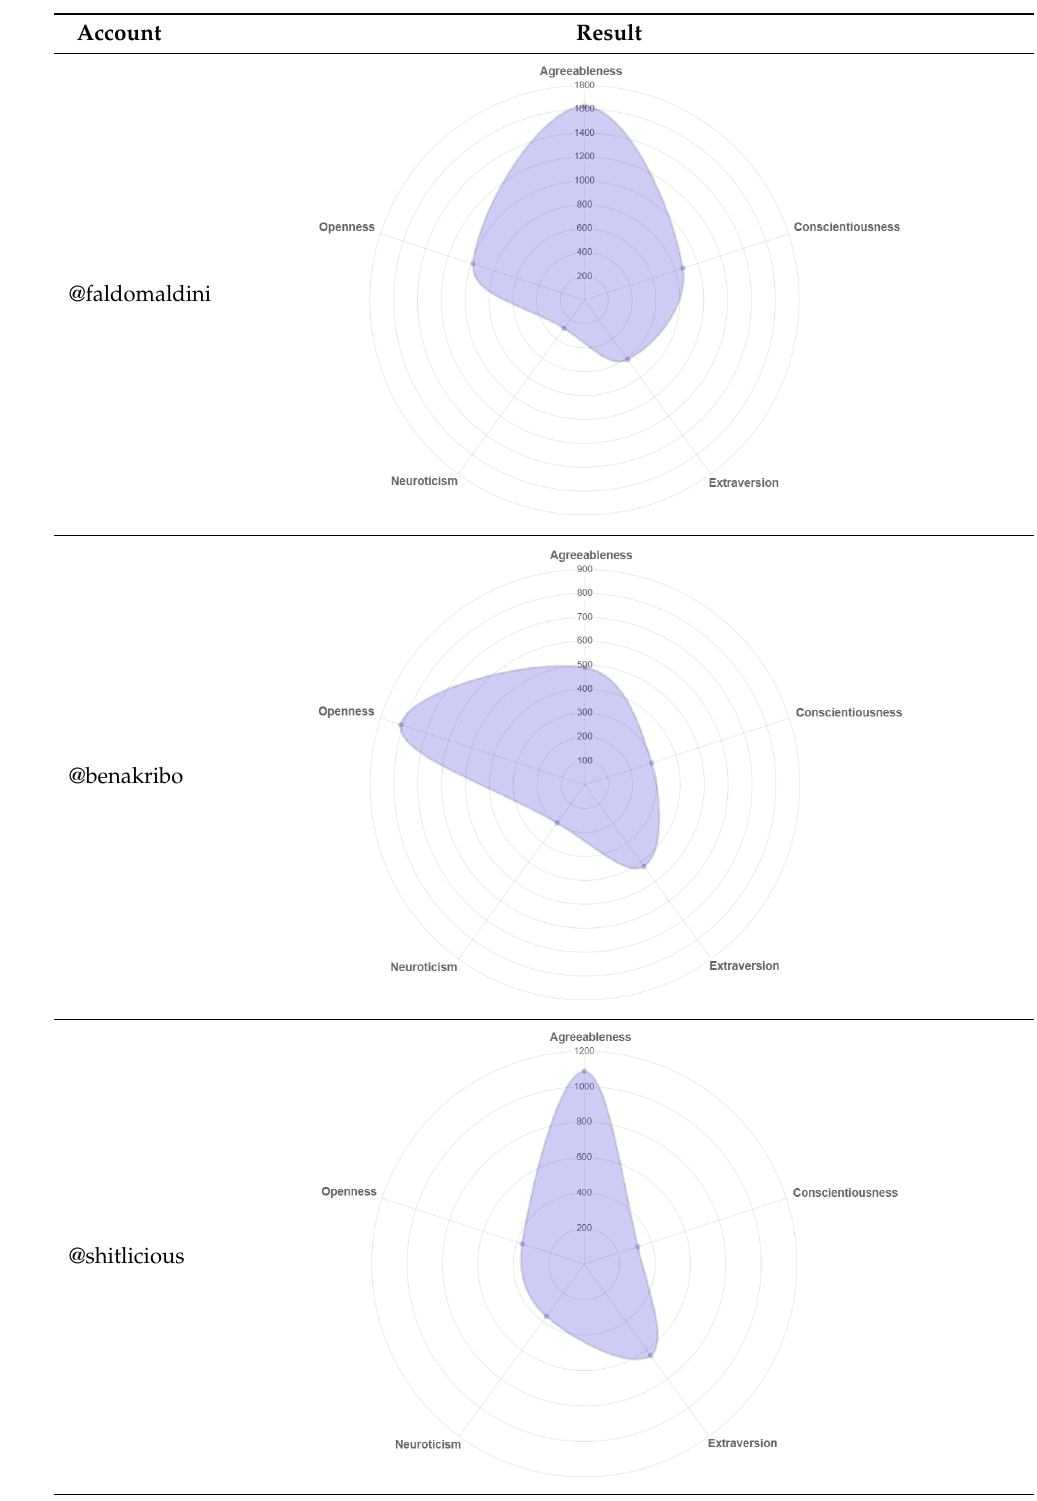
Table 5. Personality measurement results.